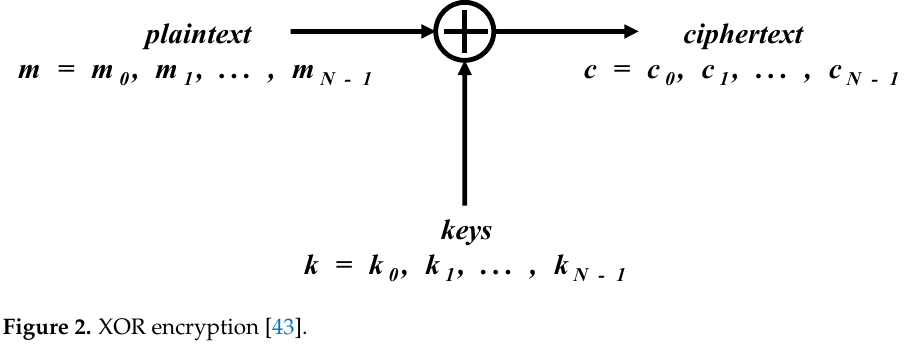
Figure 2. XOR encryption [43].